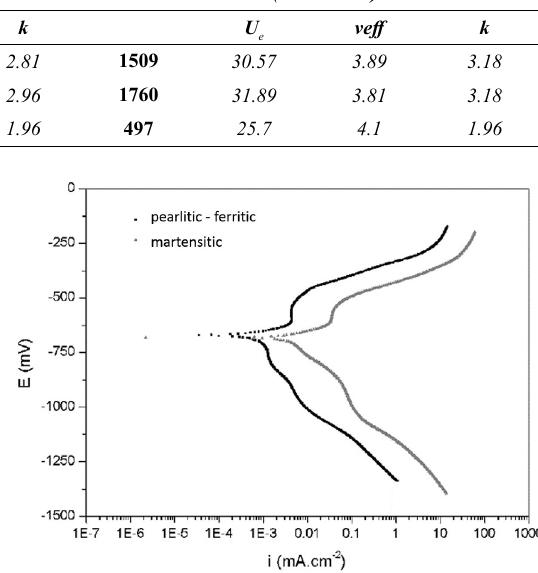
Figure 5. Potentiodynamic polarization curves for each microstructure, potential vs